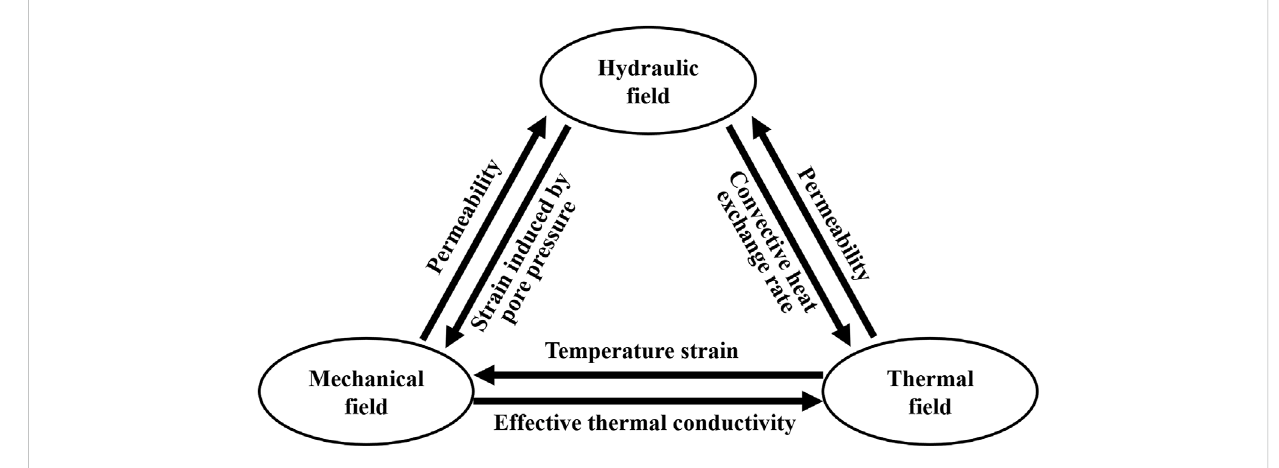
FIGURE 3 Thermal-hydraulic-mechanical coupling in the heat storage